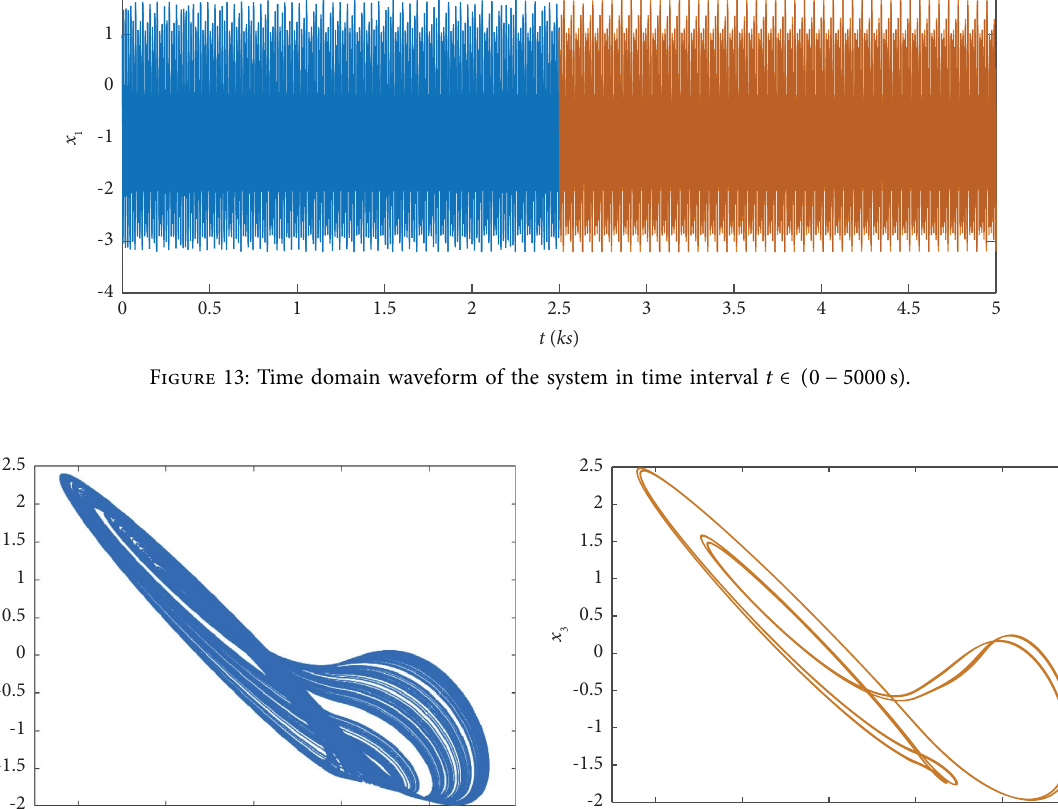
− x plane system in t ∈ ( 500s − 2500s ) interval; (b) phase diagram of 1 3